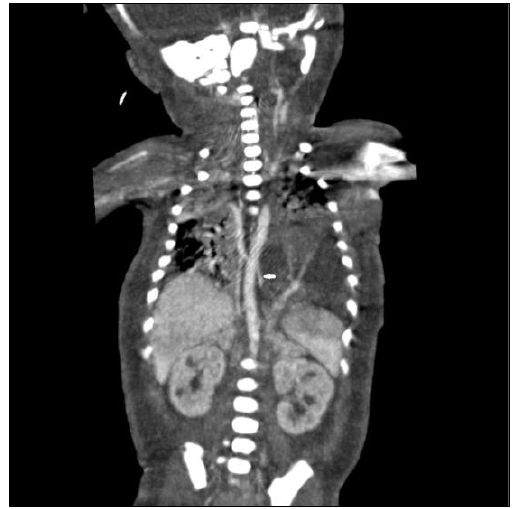
Figure 2: CT thorax showing the feeding vessel to the ELS from the